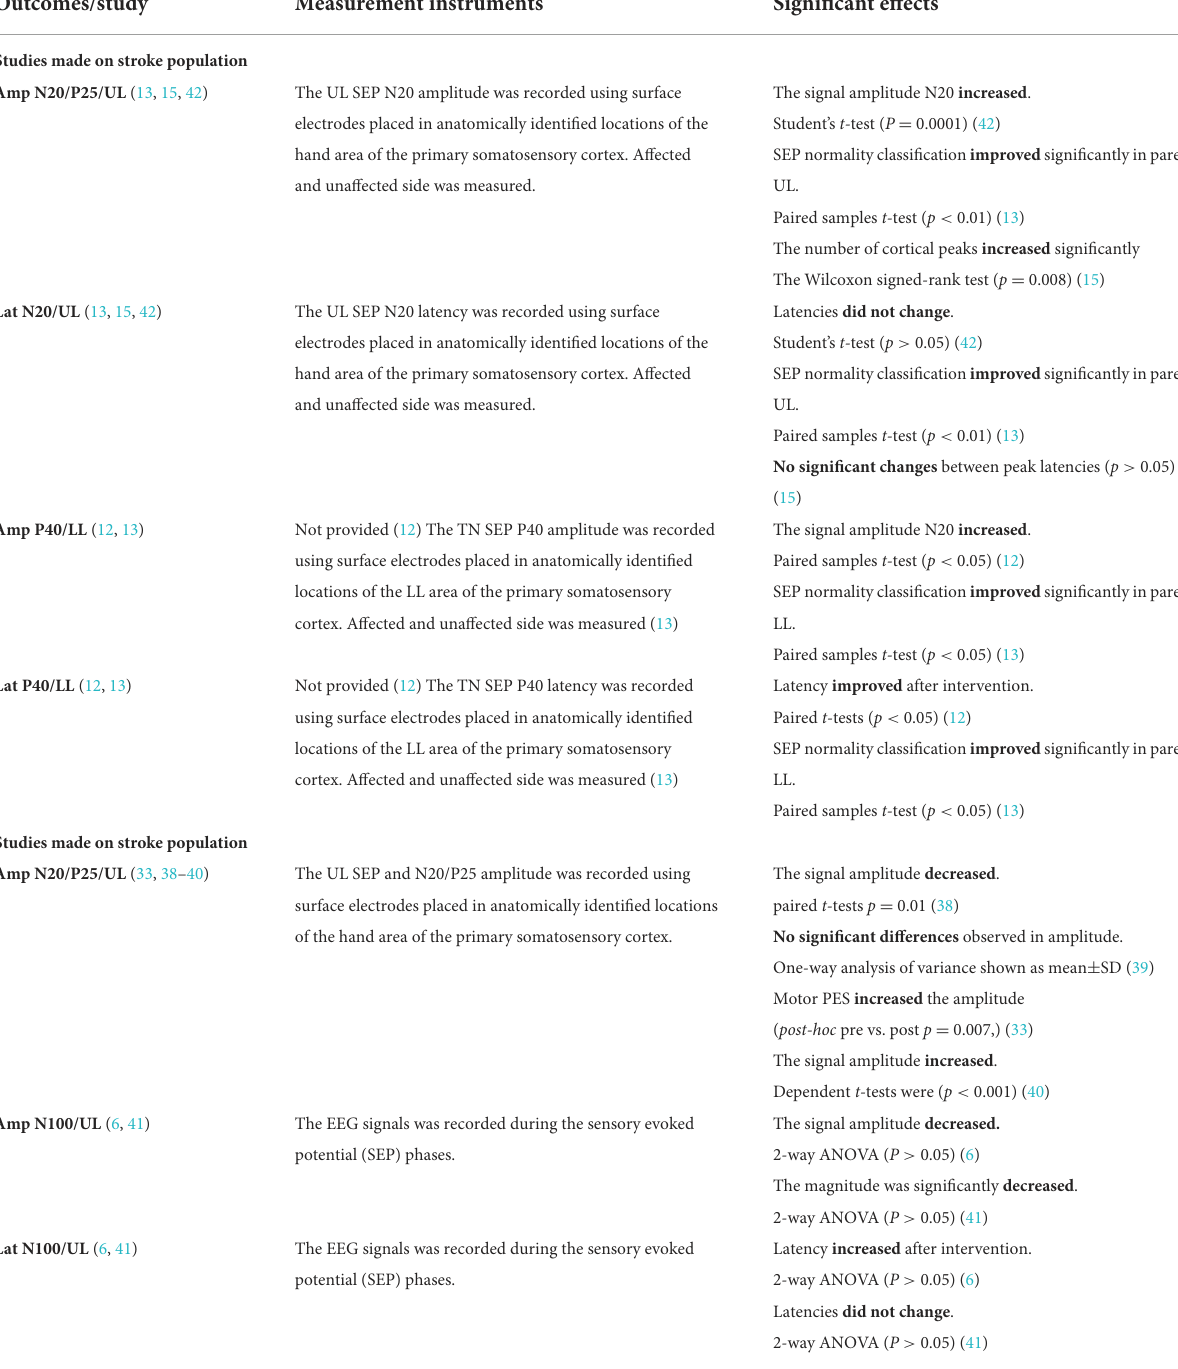
TABLE 6 SEP latency and amplitude outcomes synthesis in studies using same measurement